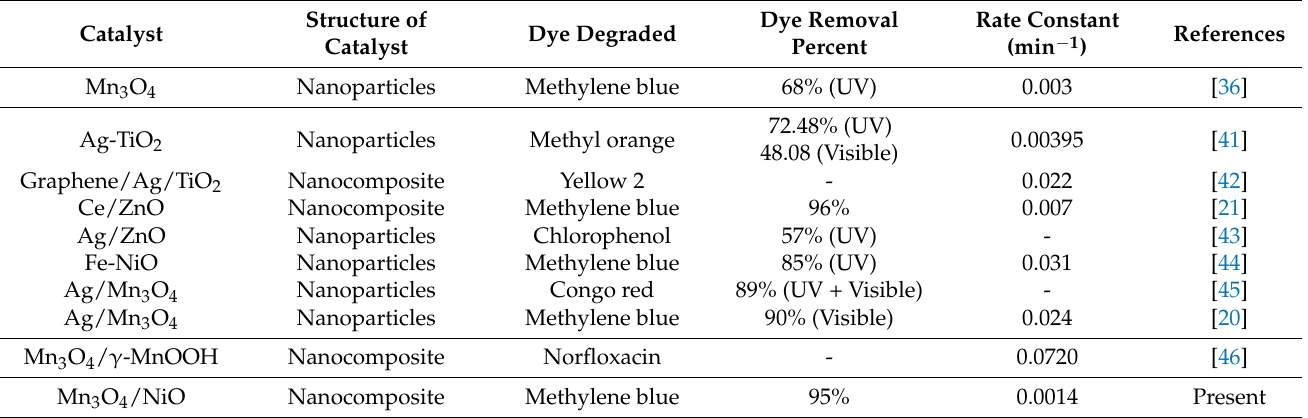
Table 2. Comparative study of the photodegradation efficiency of the proposed catalysts against reported photocatalysts in the literature.